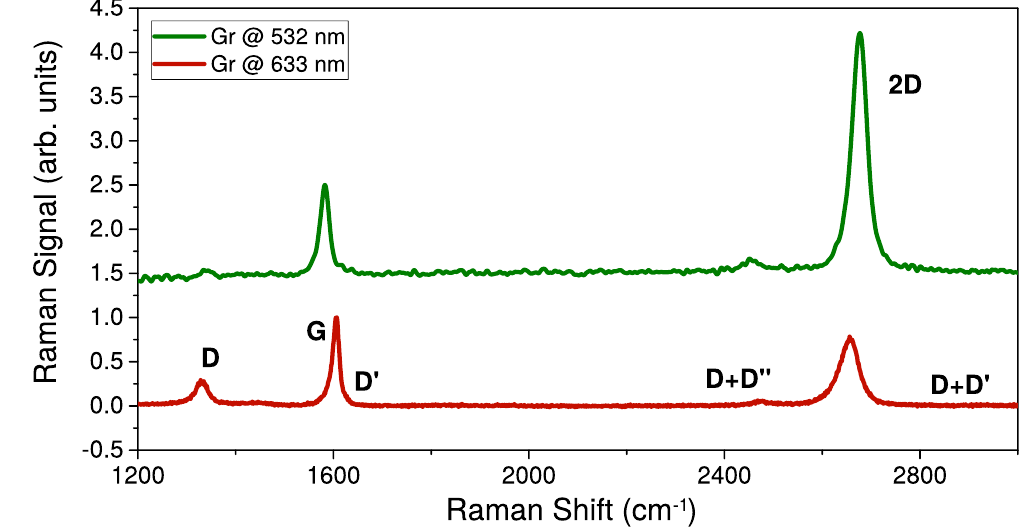
Figure 2. Raman spectra acquired by laser excitation at 532 nm (green) and 633 nm (red) of graphene (Gr) transferred on SiO 2 /Si. Labels indicate the characteristic bands of Gr. Both spectra are normalized on G band peak amplitude. Arbitrary vertical shift is